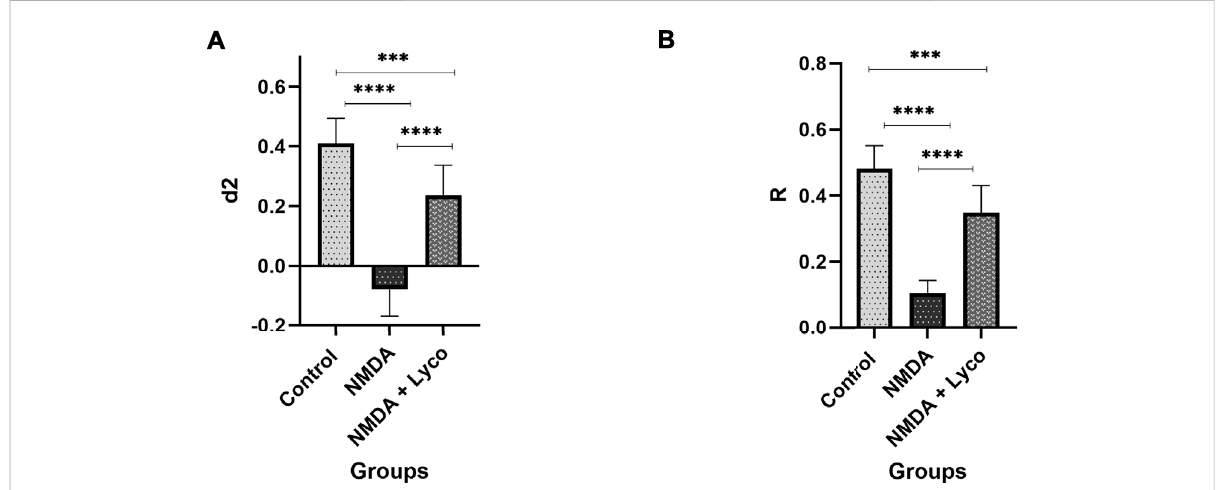
The Novel object recognition test (A) The effect of treatment with OLG1e on the d 2 index. The data are shown as means ± SEM of 10 rats per group. (* p < 0.05 and ** p < 0.01 and *** p < 0.001 and **** p < 0.0001) (B) The effect of treatment with OLG1e on the R index. The data are shown